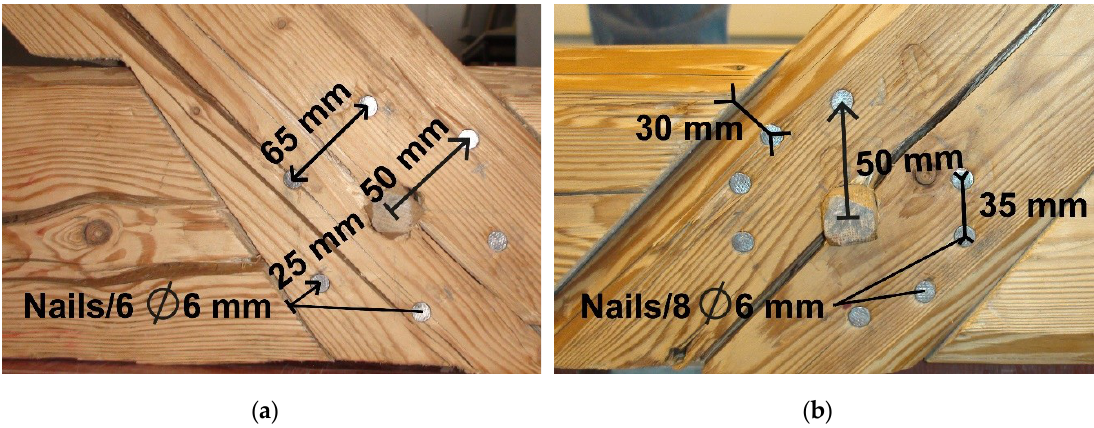
Figure 3. ( a ) Retrofitting using six mild steel nails; ( b ) retrofitting using eight steel nails.